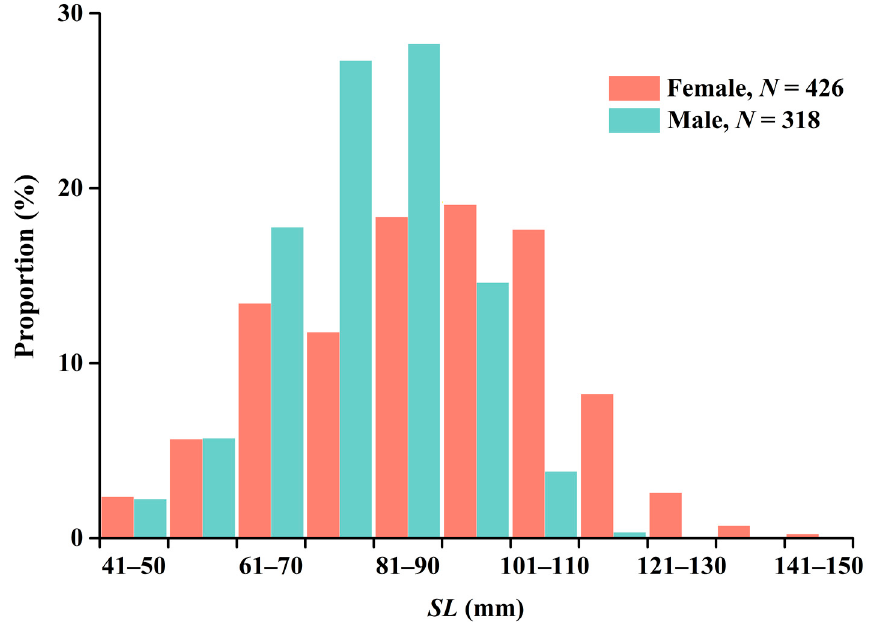
Figure 2. Frequency distribution of standard length ( SL ) of G. tibetana in the lower Yarlung Tsangpo River. Table 1. Sample size and the monthly sex ratio of the mature group of G. tibetana in the lower Yarlung Tsangpo River from December 2015 to November 2016.